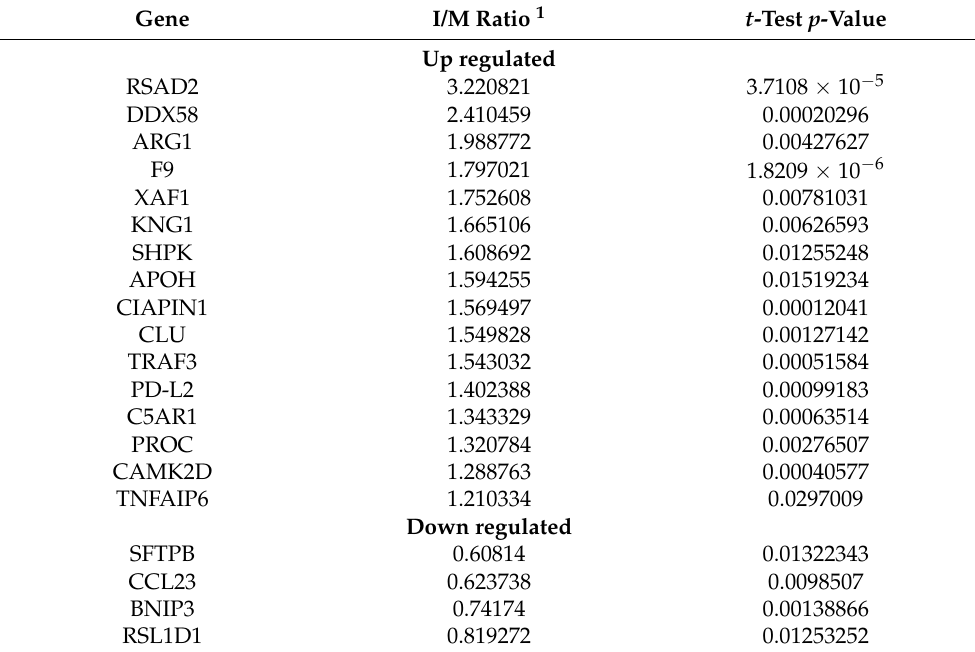
Table 3. Part of host proteins that are up- or down-regulated in ASFV infected cells. These host proteins may be related to virus replication and